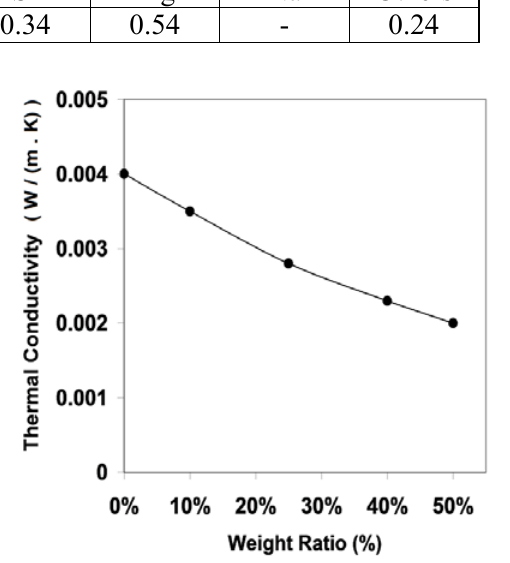
Fig. 5: Thermal conductivity varying with increased weight ratio of the cockles shells powder in the cement mortar